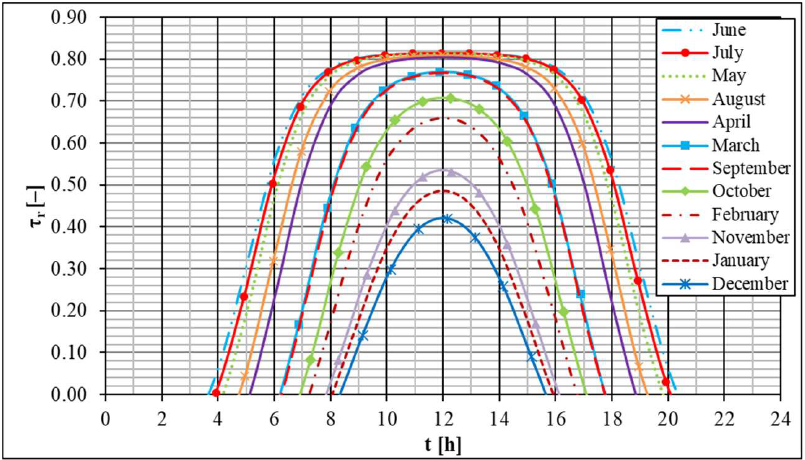
Figure 5. Transmissivity after accounting for multiple reflections of solar rays from two walls of polycarbonate ( Z = 2) as a function of time for characteristic days of